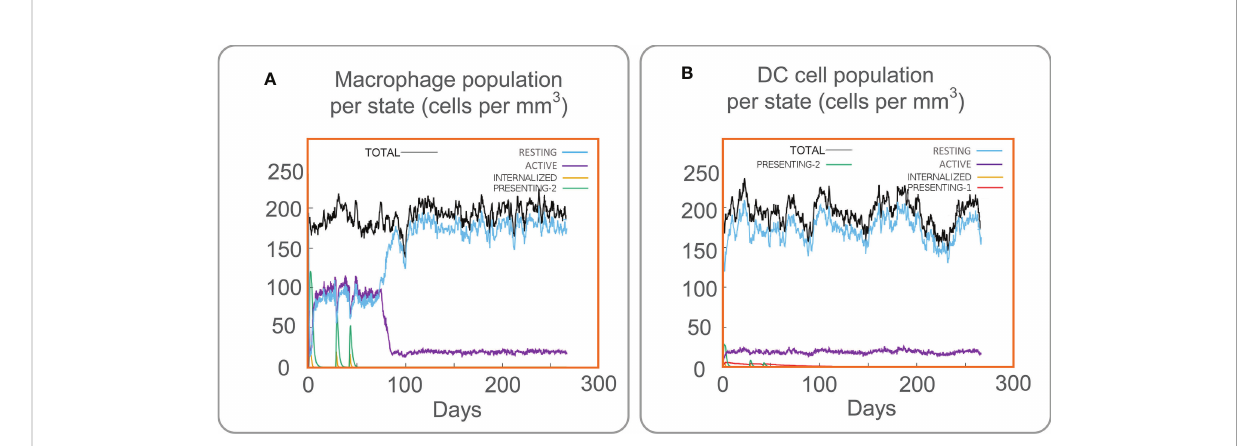
FIGURE 5 Immune stimulation of innate immune cells predicted by the C-ImmSim Server. (A) The macrophage population per state. (B) The DCs population per